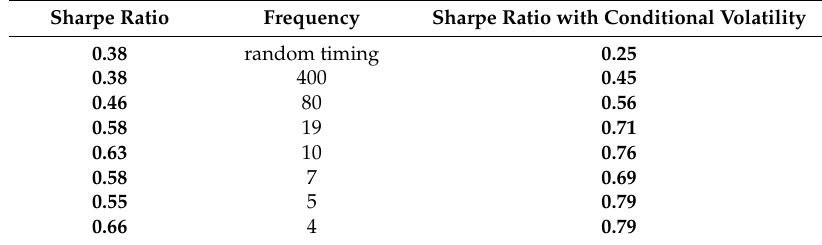
Table 6. Rolling window of 400 trading days, Sharpe ratios, data frequencies, and Sharpe ratios with conditional volatilities (bold denotes